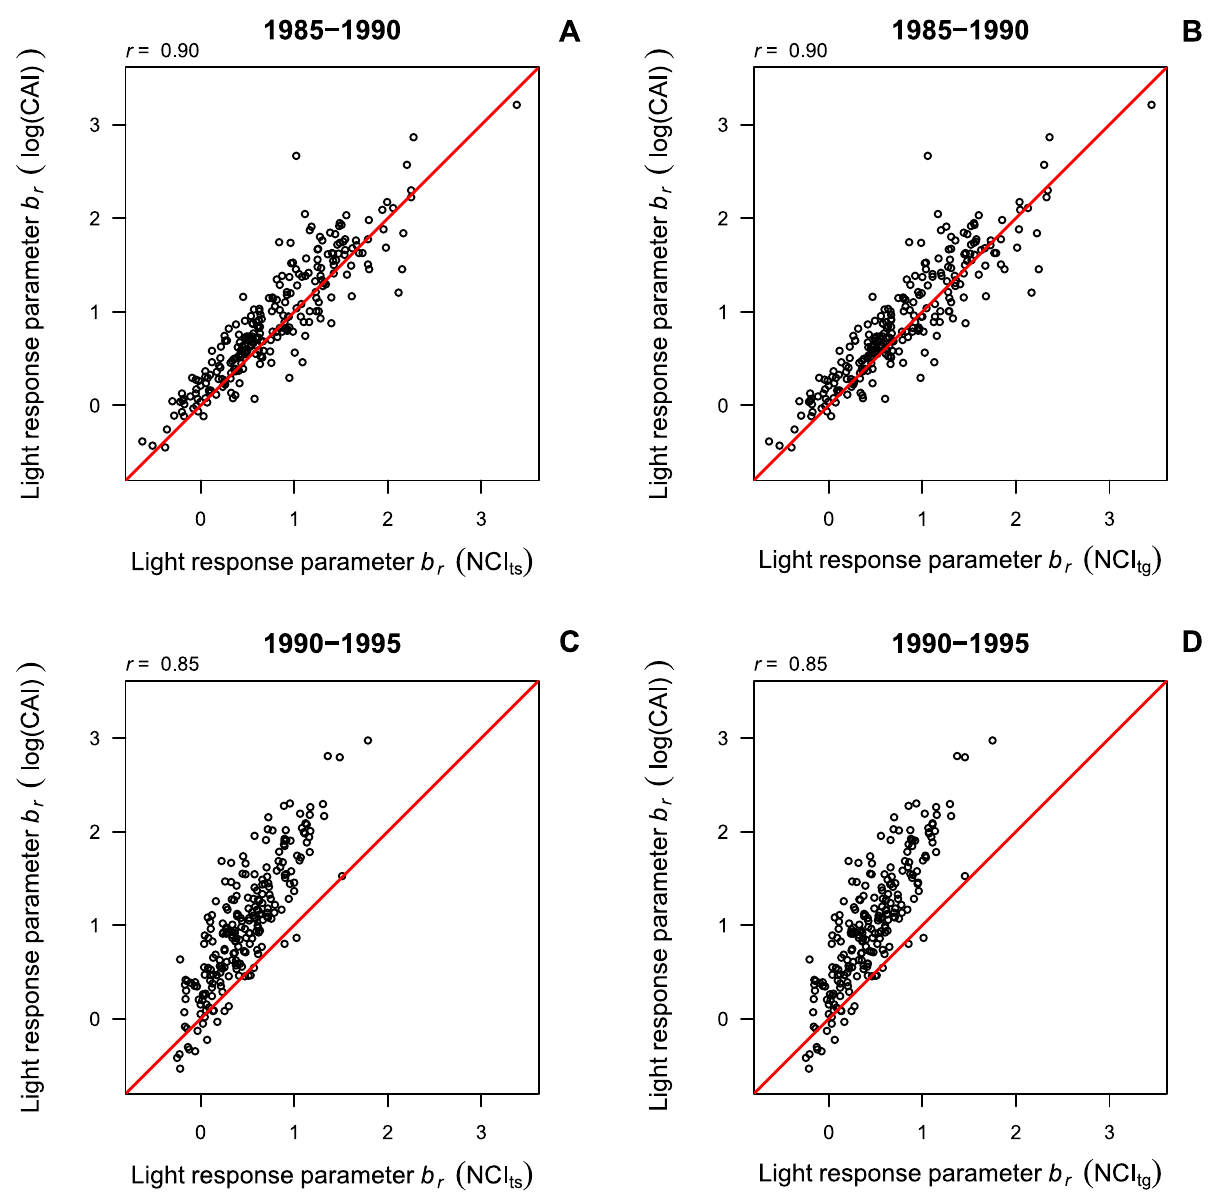
Figure 3. Species-specific light response of recruitment ( b r ) in models with neighborhood competition index versus canopy index. Panels show posterior means of b r in models with the interval-specific neighborhood competition index (NCI ts , A, C) and the general neighborhood competition index (NCI tg , B, D) compared to b r in models with the canopy index (log(CAI)). The correlation between the coefficients ( r ) and the 1:1 line are